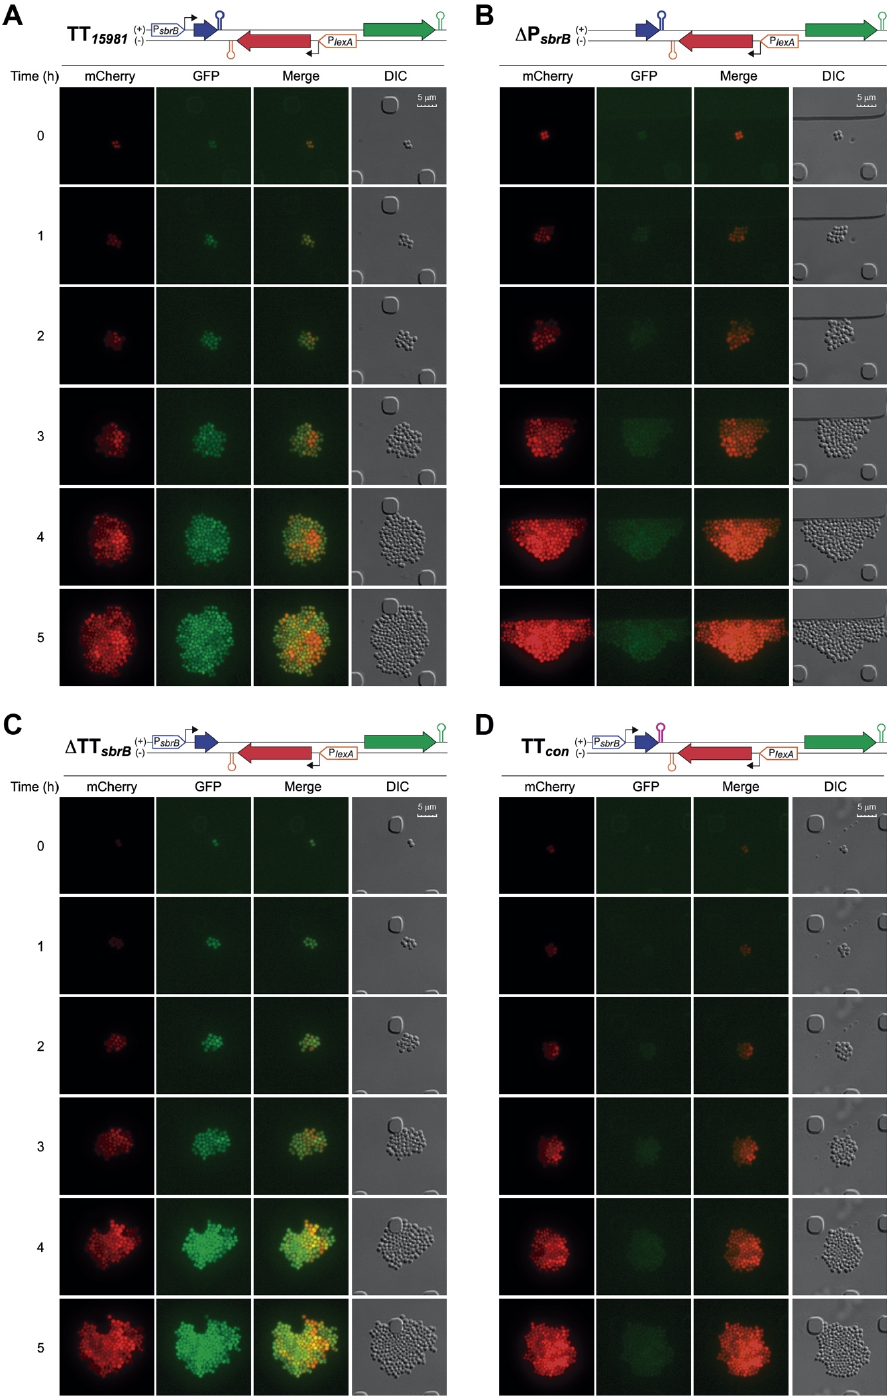
Figure 7. Regulation of heterogenous LexA expression by lexA -asRNA. Time-lapse fluorescence microscopy was performed to monitor GFP and mCherry expression at the single-cell level in S. aureus 15981 strains carrying one of the four dual fluorescent plasmid reporter variants: ( A ) TT 15981 , ( B ) ∆ P sbrB , ( C ) ∆ TT sbrB and ( D ) TT con . The main genetic elements of these constructions are illustrated on top of each corresponding panel. Bacteria were grown at 37 ◦ C in CellAsic microfluidic plates with a continuous flow of MHg and challenged with 30 mM of KOH for 4 h. Images were taken in 15 min intervals. The mCherry and GFP fluorescence, the combination of both signals (merge panels) and the differential interference contrast (DIC) images are shown. Quantification of bacterial growth and single-cell GFP and mCherry levels are shown in Supplementary Figure